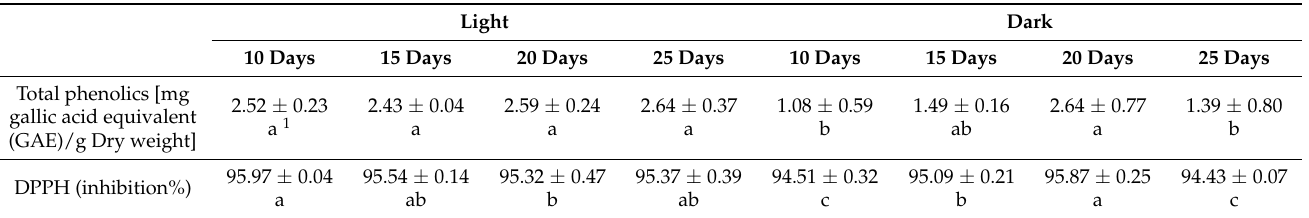
Table 3. TPC and DPPH assay of P . frutescens microgreens grown under long-day photoperiod or continuous darkness